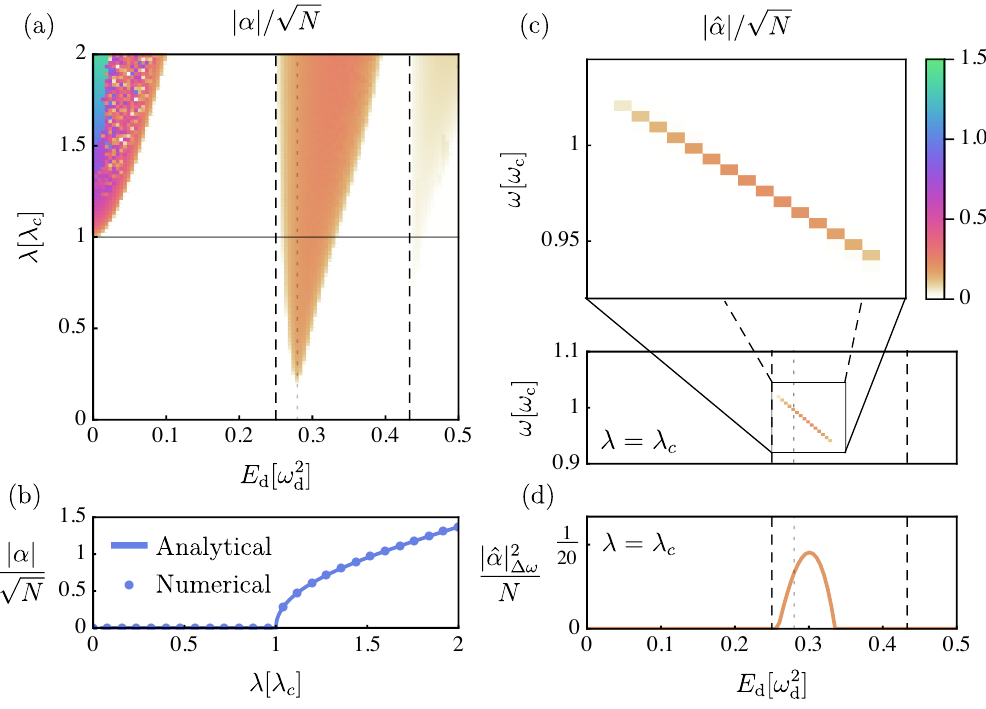
Figure 2: In panel (a) we show the magnitude of the photonic field α as a func- tion of the driving field strength E and the coupling strength λ . For large E , the d d Floquet-assisted superradiant phase (FSP) emerges and exhibits an oscillating pho- → 0 limit, i.e. the Dicke superradiant tonic steady state. In panel (b) we show the E d transition, which is predicted very well analytically. In panel (c) we show the mag- (cid:112) N as a function of the driving field strength E nitude of the Fourier transform | ˆ α | / d for the coupling strength λ = λ . In the FSP, the steady state frequency of the cavity c is close to the cavity frequency. We also show a zoomed-in version of the regime N − 1 of in which the FSP occurs. In panel (d) we show the power spectrum | ˆ α | 2 ∆ ω the FSP integrated over the frequencies shown in (c) in order to compensate for the frequency shift of the FSP as a function of E . The dashed lines in (a), (c) and (d) d indicate the analytically determined lower bound for the FSP, see Eqs. 25 and 26. The dotted lines in (a), (c) and (d) indicate the driving field strength at which the Floquet energy spacing is equal to the cavity